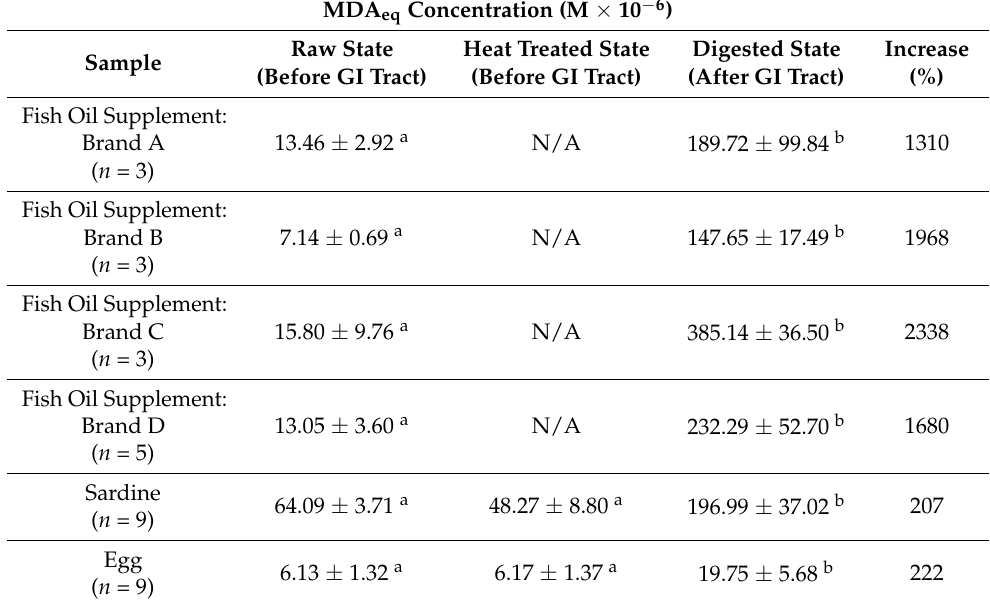
Table 2. TBARS results before and after digestion.